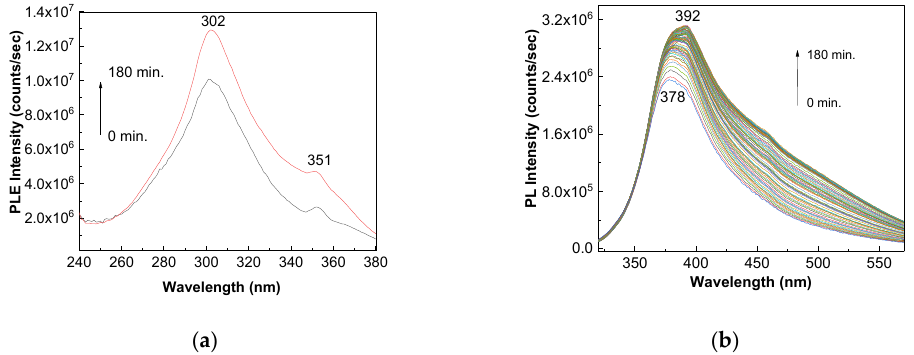
3802.0x10 240 260 280 300 320 340 360 Figure 6. PLE ( a ) and PL ( b ) spectra of the LO aqueous solution and their evolution under UV light. With this in the mind, Figures 7 and 8 show the PLE and PL spectra of NaOH ‐ reacted LP ( 1 ) and LO, respectively. Thus, the NaOH ‐ reacted LP ( 1 ) highlights: (i) in dark condi ‐ tions, an intensity growth of PLE band from 1.19 × 10 6 (Figure 7a 1 ) to 8.71 × 10 6 counts/sec (Figure 7b 1 ) and 1.98 × 10 7 counts/sec (Figure 7c 1 ), simultaneous with the intensity increase of the PL spectrum from 1.02 × 10 5 counts/sec (Figure 7a 2 ) to 1.53 × 10 6 counts/sec (Figure 7b 2 ) and 1.64 × 10 6 counts/sec (Figure 7c 2 ). These changes are accompanied by a shift of the PLE and PL bands from, 307 nm and 379 nm (Figure 5) up to 310 nm and 398 nm, respec ‐ tively (Figure 7). These variations indicate the emergence of a new luminescent center in the case of NaOH ‐ reacted LP( 1 ). The effect of UV light on the three samples of NaOH ‐ reacted LP ( 1 ), time of 3 h, consists of an intensity decrease in both (i) the PLE spectrum, i.e., up to 6.98 × 10 5 counts/sec (Figure 7a 1 ) to 1.95 × 10 6 counts/sec (Figure 7b 1 ) and 4.22 × 10 6 counts/sec (Figure 7c 1 ), and; (ii) the PL spectrum, namely up to 2.3 × 10 4 counts/sec (Figure 7a 2 ), 8.84 × 10 4 counts/sec (Figure 7b 2 ) and 2.65 × 10 5 counts/sec (Figure 7c 2 ).